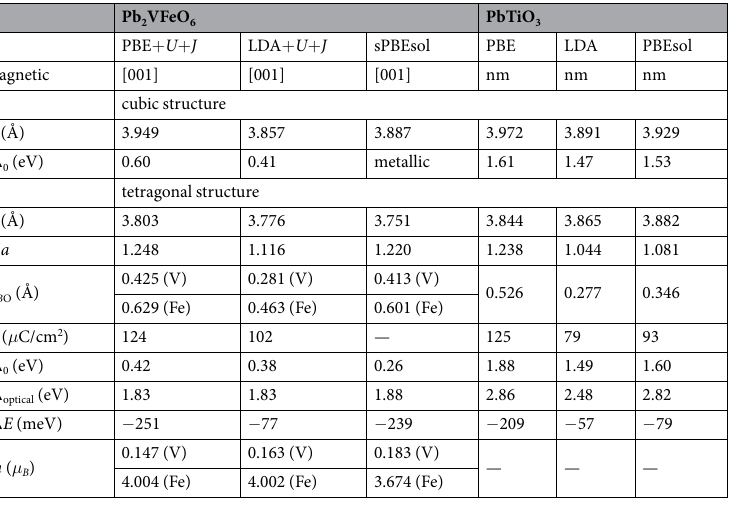
Table 2. Comparison of Pb 2 VFeO 6 and PbTiO 3 . The results are calculated using the DFT method with different exchange correlation functionals (xc). ‘nm’ stands for non-magnetic and ‘[001]’ for the [001] antiferromagnetic ordering. For the cubic case, a is the lattice constant and Δ 0 is the fundamental gap. For the tetragonal case, a is the in-plane lattice constant, c / a is the ratio of out-of-plane lattice constant over in-plane lattice constant, δ B O is the B -site metal and oxygen displacement along the [001] direction. Δ 0 is the fundamental gap and Δ optical is the optical gap. Δ E is the energy difference between the tetragonal structure and the cubic structure in the unit of meV per 5-atom formula. P is the polarization along the [001] direction. m is the local magnetic moment on V and Fe sites.